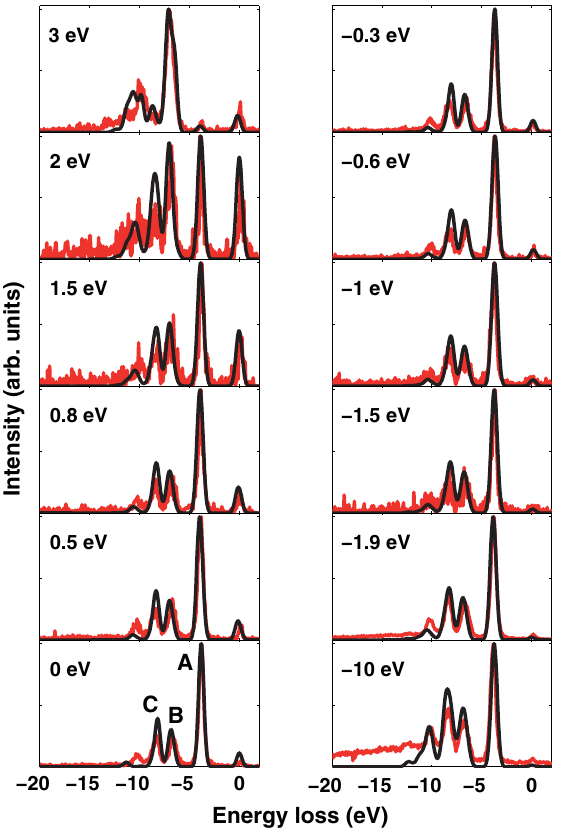
FIG. 2. Experimental (red line) and calculated (black line) S K β RIXS spectra of the CS 2 molecule for different values of the incident photon-energy detuning Ω from the 1 s → 3 π LUMO u resonance. At the 3 π resonance (2470.4-eV photon energy, u Ω ¼ 0 eV), the major emission bands labeled as A, B, and C are 3 π 1 3 π 1 assigned as transitions to the final states j 2 π − 1 , j 2 π − 1 , g u i u u i 3 π 1 and j 5 σ − 1 , respectively. The error bars on the peak intensities u u i reflect the experimental statistical